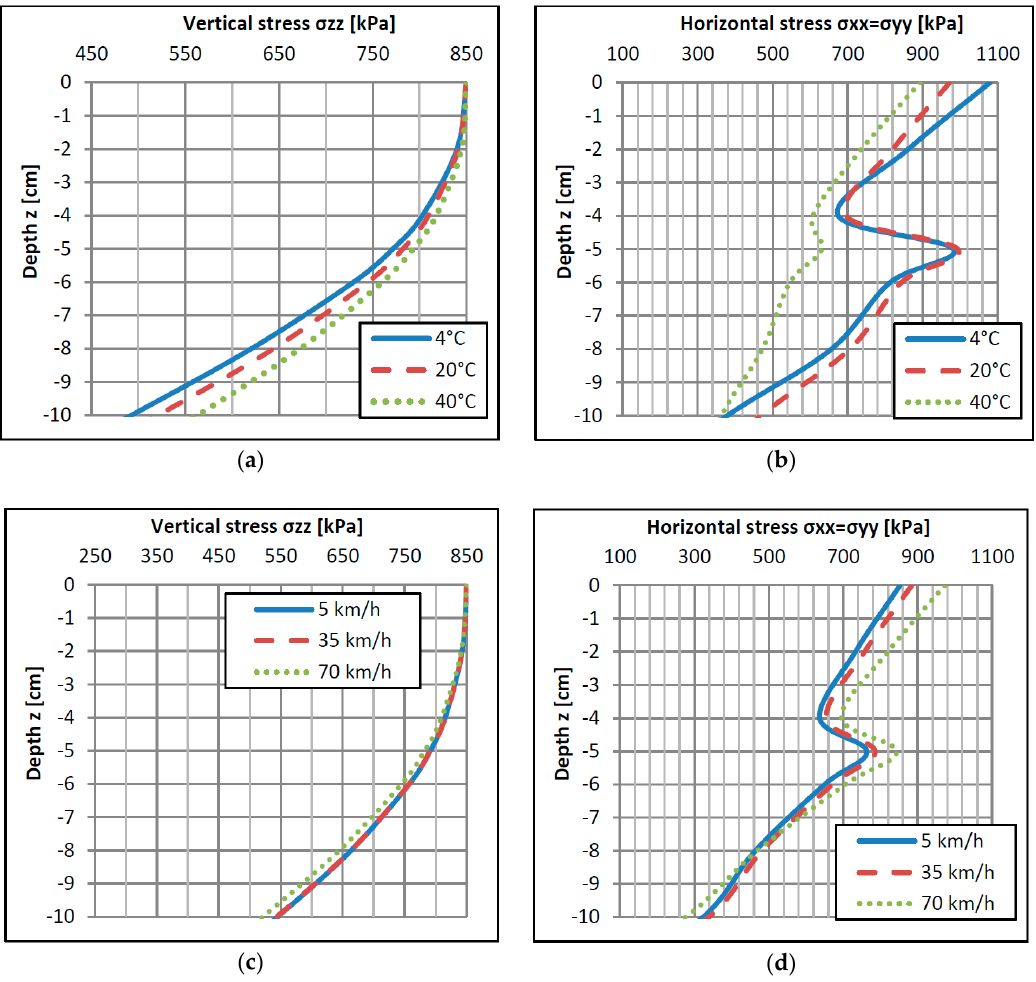
Figure 9. Distribution of normal stresses on the pavement structure depth under wheel load p = 35 kN, contact stress q = 850 kPa: ( a , b ) at a constant speed of 70 km/h and various temperatures; ( c , d ) at a constant temperature of 20 °C and various vehicle speeds.